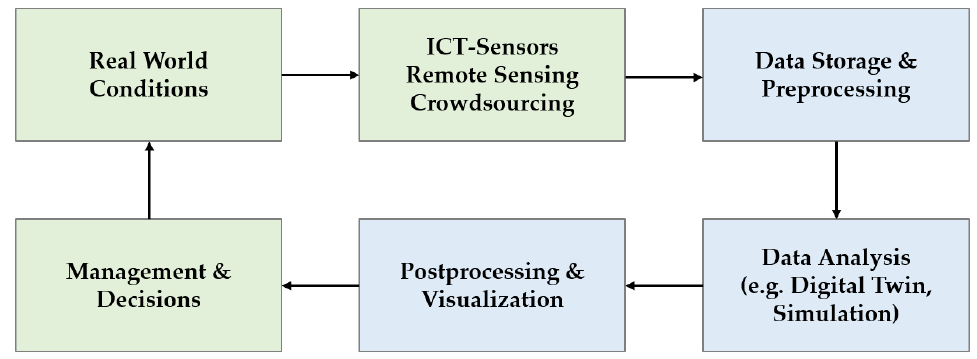
Figure 1. Flow chart for smart disaster management (green: real world, blue: virtual realm).